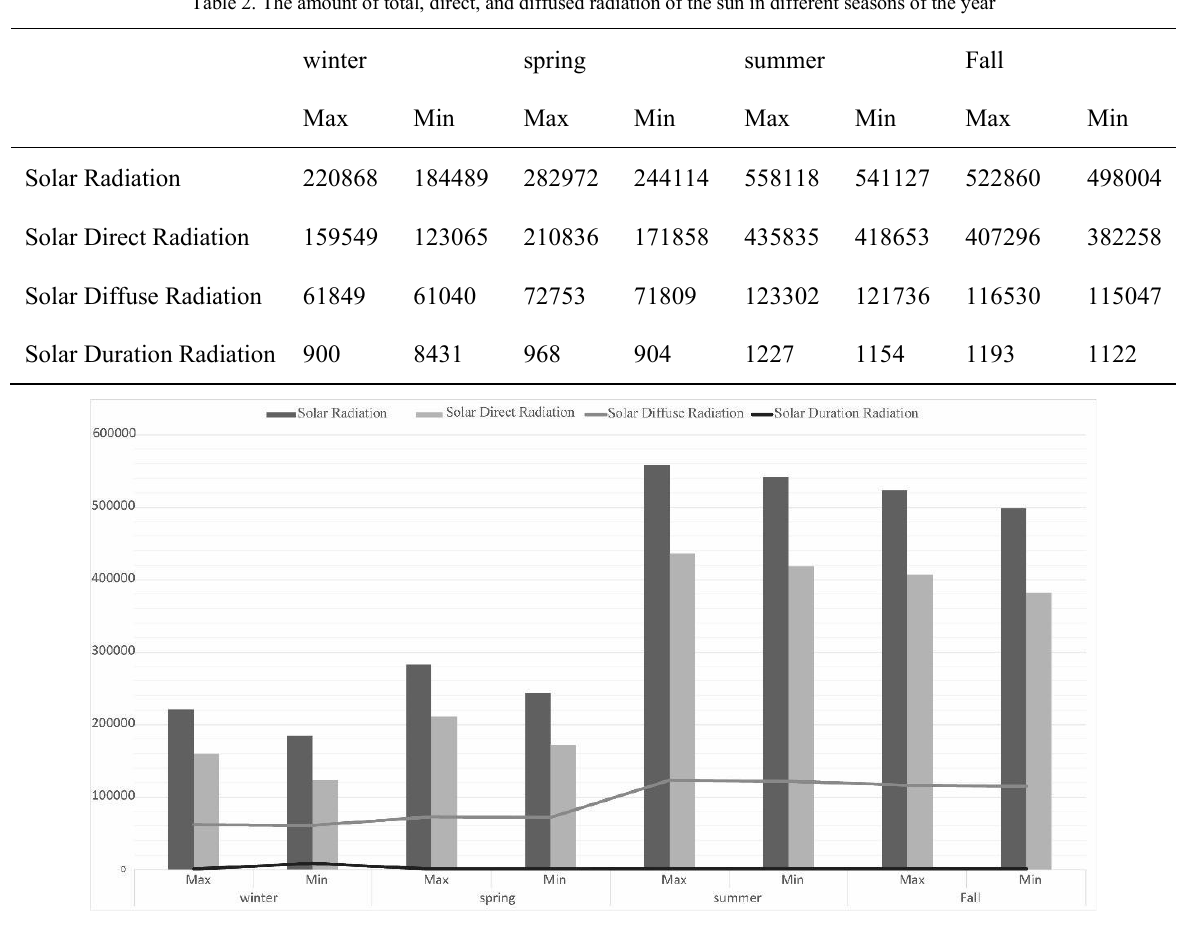
Figure 5 - Bar chart comparing different amounts of solar radiation in different seasons